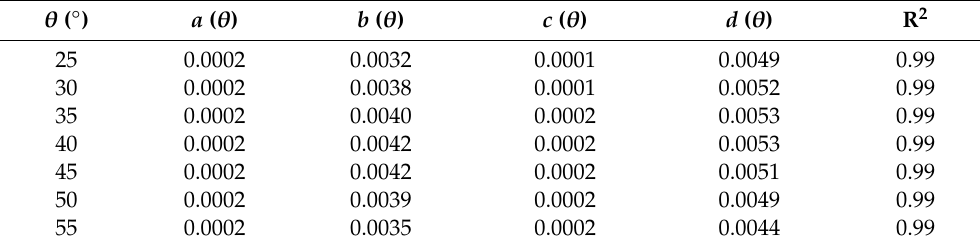
Table 6. Empirical coe ffi cients at di ff erent incidence angles in VH polarization ( Hrms ∈ (0.5, 2.5) cm). θ ( ◦ ) a ( θ